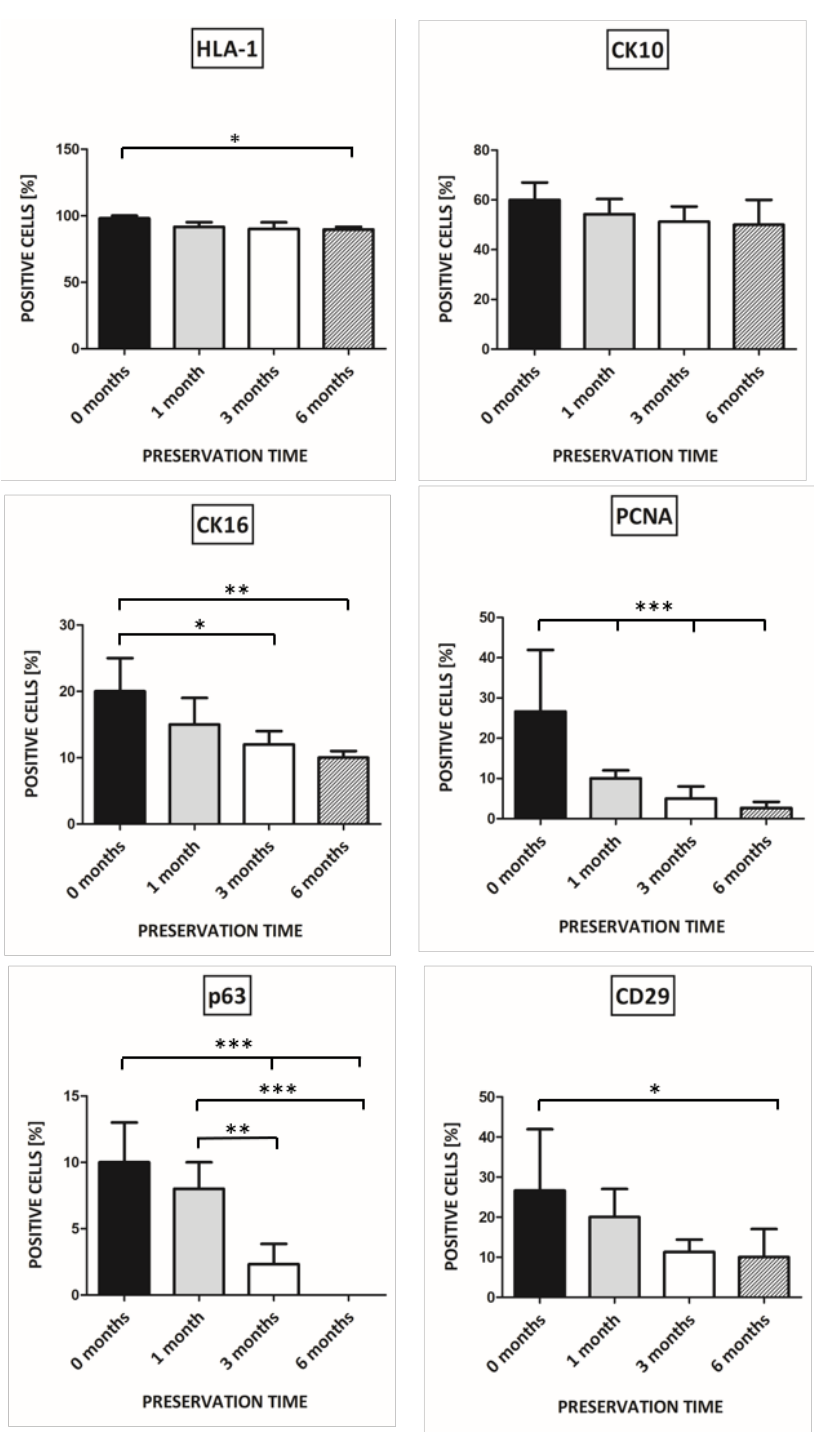
Figure 6. The percentage of keratinocytes in newly formed epidermis positive for HLA-1, CK10, CK16, PCNA, p63, and CD29 depending on the time of preservation. Statistically significant results are shown at the bar graph (* p < 0.05, ** p < 0.01, *** p < 0.001).